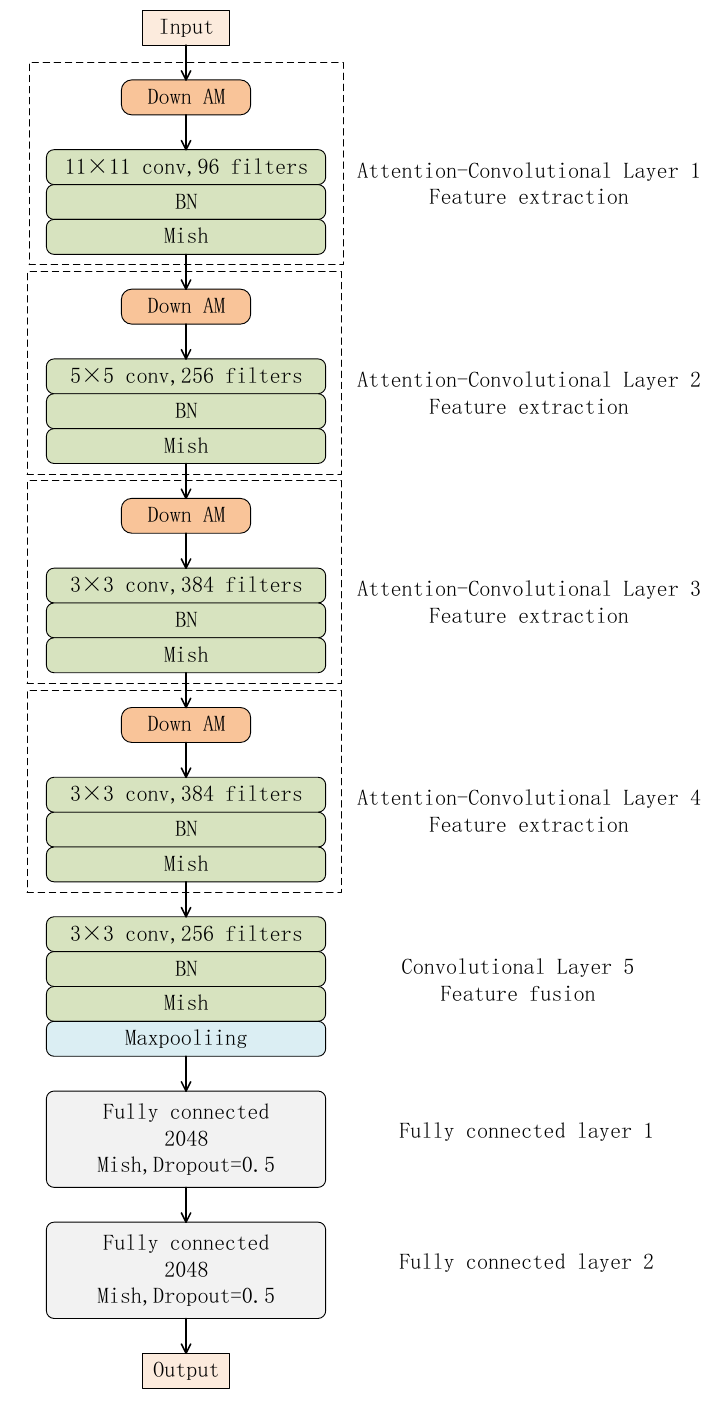
Figure 6. Computation flow of AT-AlexNet model for corn disease identification.